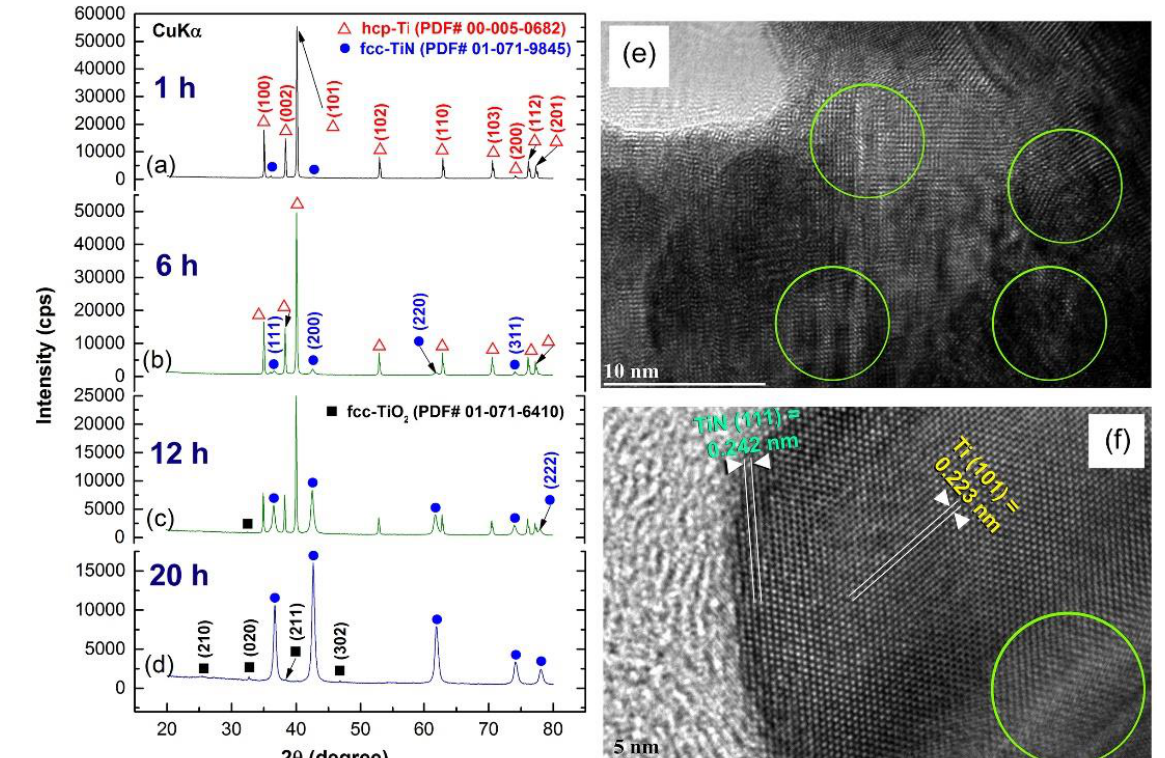
Figure 29. XRD diffraction patterns of Ti powder samples after ( a ) 1 h, ( b ) 6 h, ( c ) 12 h, and ( d ) 20 h of RBM. The HRTEM images of samples milled for 1 h and 3 h, respectively, are presented in ( e ) and ( f ).